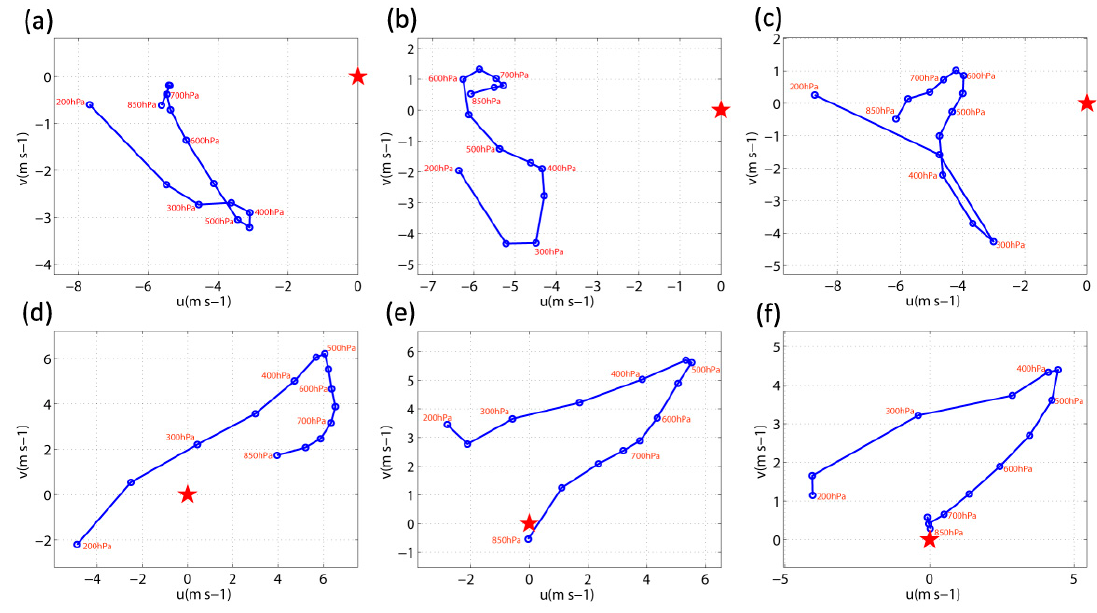
Figure 8. Environmental mean wind profile of CTRL ( a , b ), SN1 ( b , e ), SN3 ( c , f ) at 0600 UTC 18 ( a – c ) and 0600 UTC 20 ( d – f ). The stars in the figure represent the coordinate system’s origin.